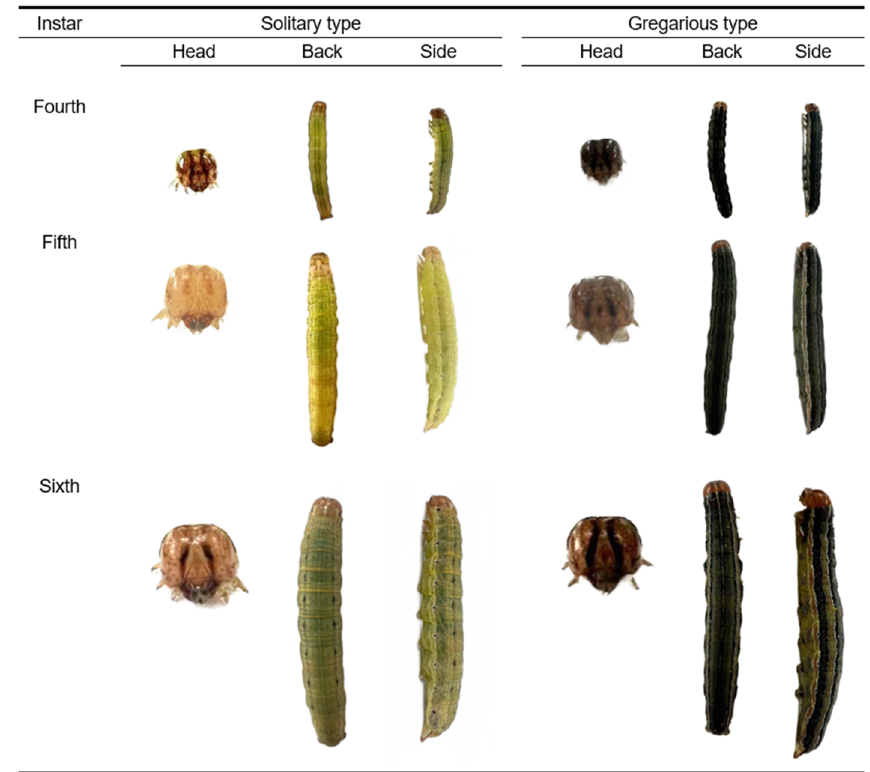
Figure 1. Phenotypes of gregarious and solitary armyworms at different instars.